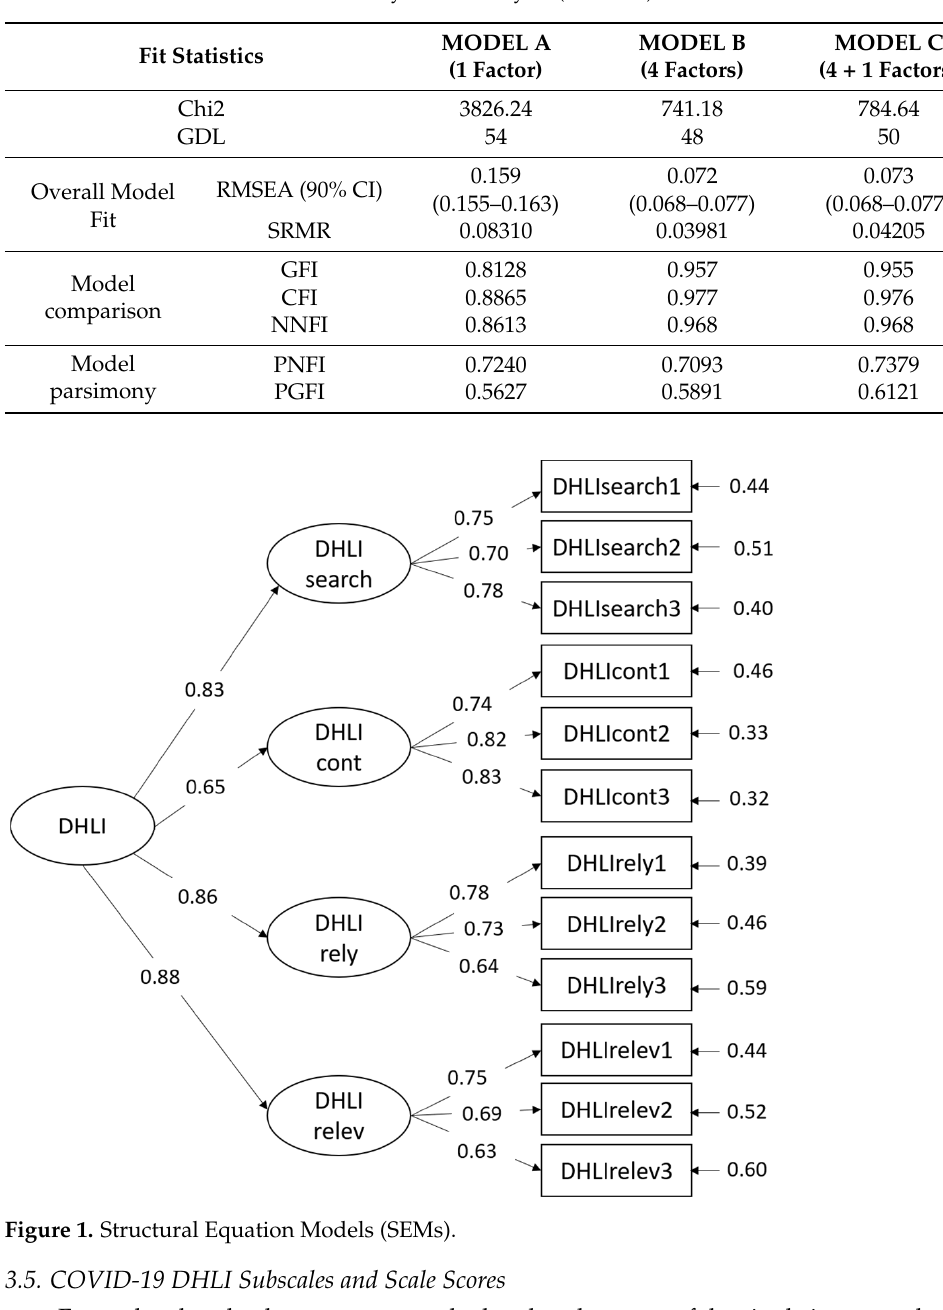
Table 5. Fit statistics of the confirmatory factor analysis ( n = 2770).